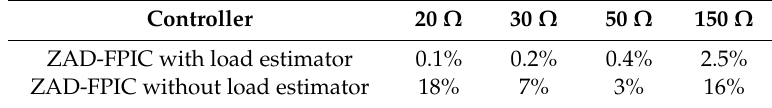
Table 5. Error in the controlled